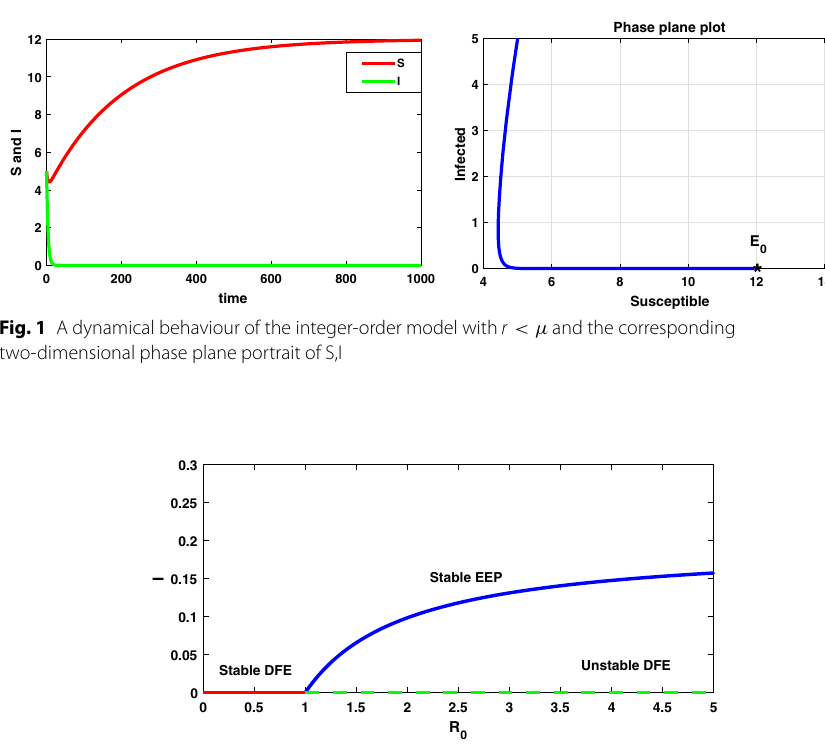
Fig. 2 A forward bifurcation diagram of R 0 with the change of parameter β on the infected population for the integer-order model with r < µ is shown